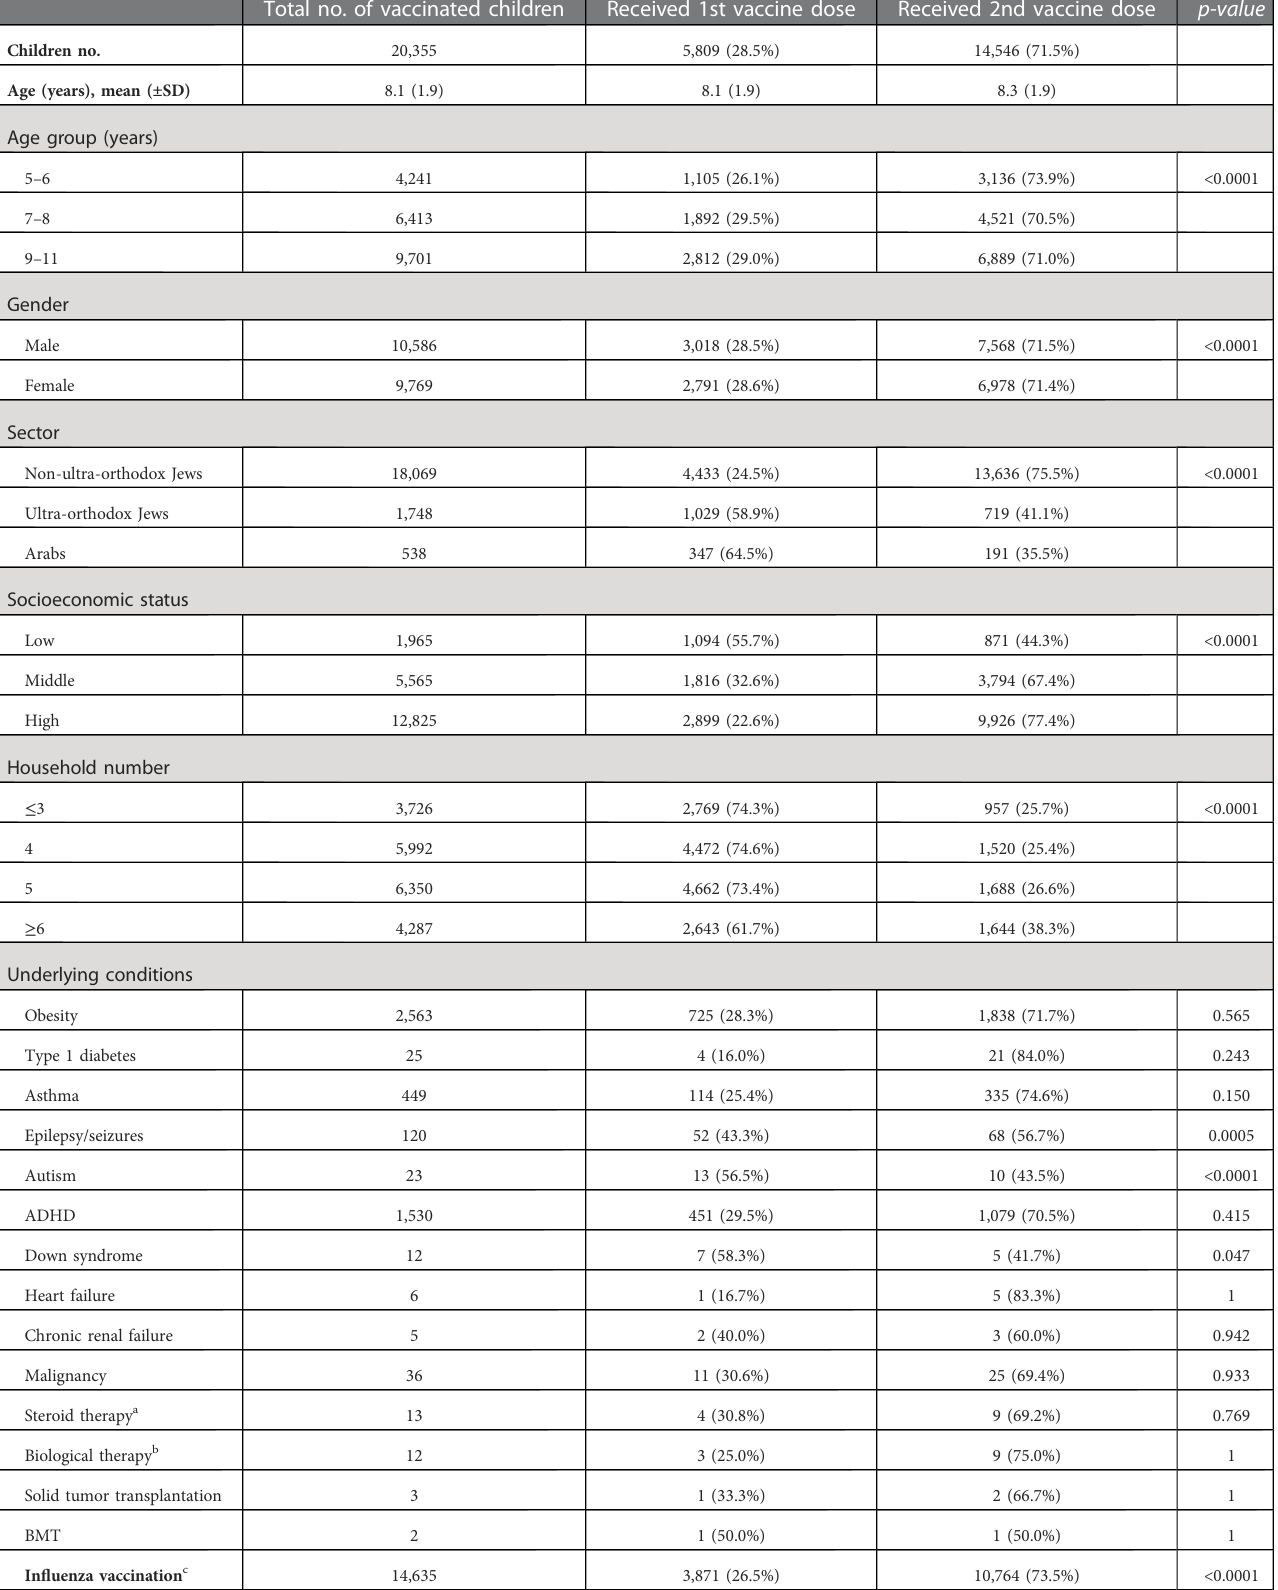
TABLE 2 Characteristics of the study group by number of COVID-19 vaccine doses